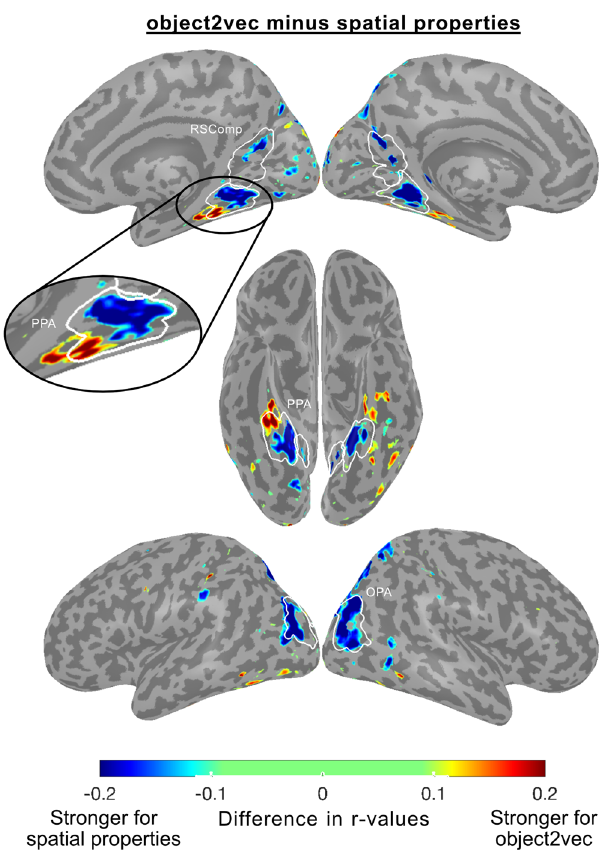
Fig. 9 Whole-brain voxel-wise preference map for visual context (object2vec) vs. object spatial properties. This preference map shows differences in model performance for the object2vec encoding model and the spatial-properties encoding model. Voxel-wise difference scores were calculated by subtracting prediction accuracy for the spatial properties model from prediction accuracy for the object2vec model. Warm colors indicate voxels that were better explained by object2vec and cool colors indicate voxels that were better explained by spatial properties. Difference scores are plotted for voxels that show a signi fi cant preference for either model ( p < 0.05, FDR-corrected, one-sided permutation test). There are clusters of signi fi cantly greater prediction accuracy for object2vec relative to spatial properties in the anterior PPA and in the parahippocampal cortex beyond the anterior PPA boundary. There are clusters of signi fi cantly greater prediction accuracy for spatial properties relative to object2vec in posterior PPA and the other scene-selective ROIs (OPA and RSComp). ROI parcels are shown for scene-selective ROIs. PPA parahippocampal place area, OPA occipital place area, RSComp retrosplenial